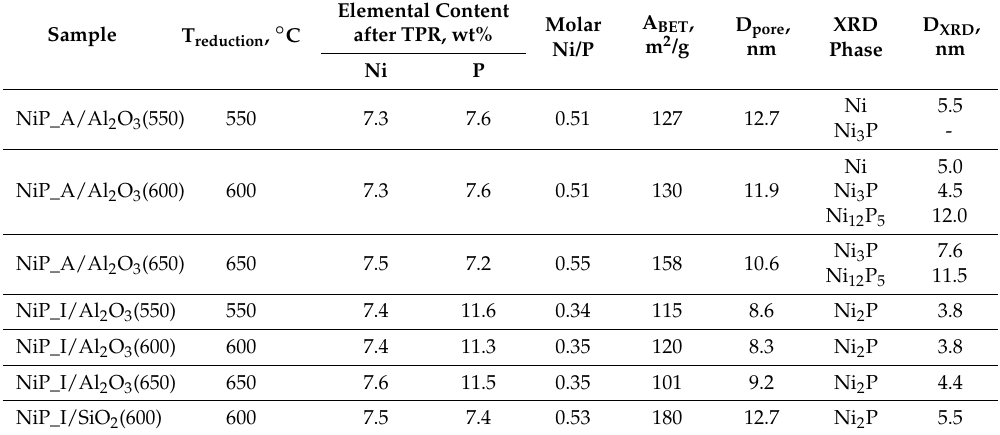
Table 1. Physicochemical properties of NiP_A/Al 2 O 3 , NiP_I/Al 2 O 3 and NiP_I/SiO 2